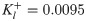
Flow visualization at the end of the 5th wingbeat (t = 23.78 ms) for the simplified kinematics cases.Iso-surfaces Q/f2 = 15 are shown for 4 different takeoffs IGE: (a) Kl+=0.0095 N/m; (b) Kl+=0.0184 N/m; (c) Kl+=0.0307 N/m; (d) Kl+=0.0430 N/m.